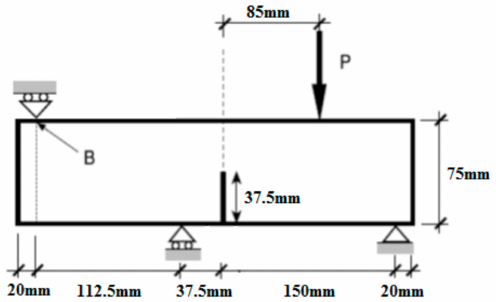
Figure 7. Asymmetric notched four-point bending beam.